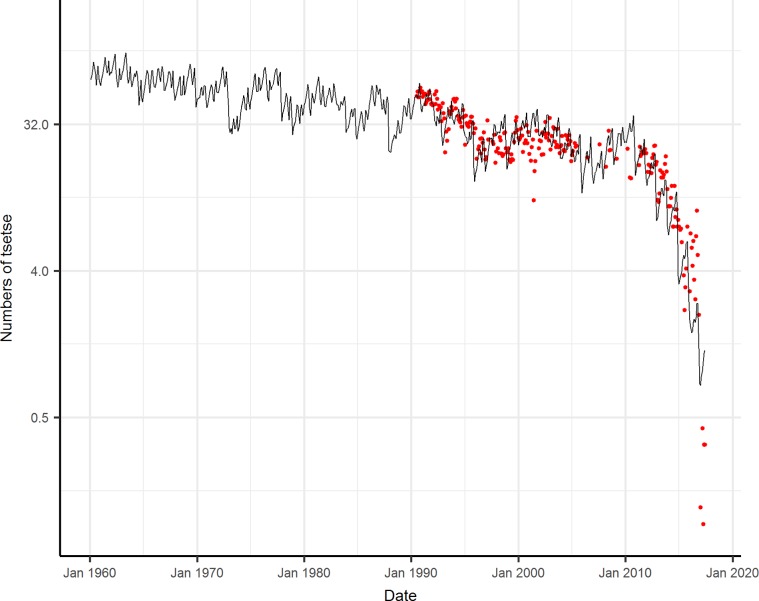
Observed (points) and modelled (line) changes in numbers of G. pallidipes females caught between 1960 and 2017.Data, on log base 2 scale, from 1990 to 2017, are average numbers caught by hand net, per afternoon, using an ox-bait. Fitted parameters are provided in Table 1.